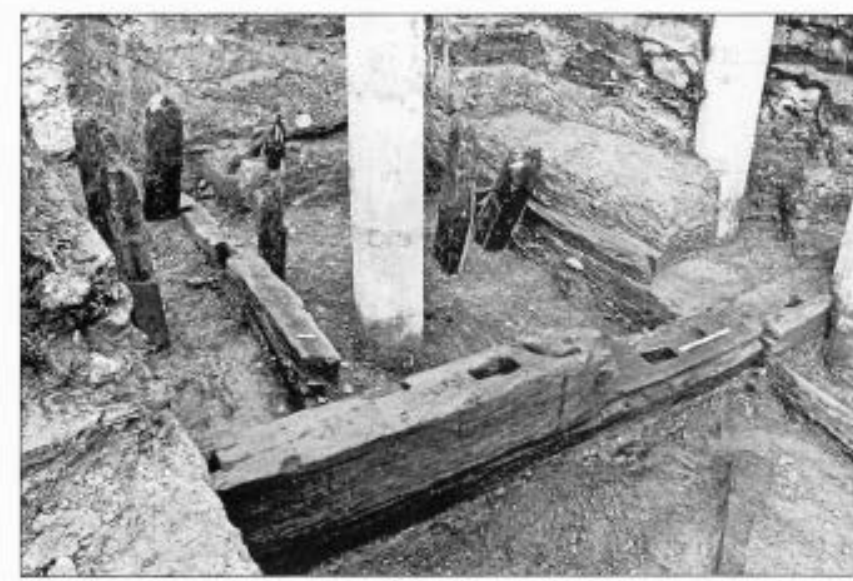
Figure 4 The remains of an oak-timber Roman quay of the third century AD at the Thames Exchange site in the City of London (right foreground: scale bar 50